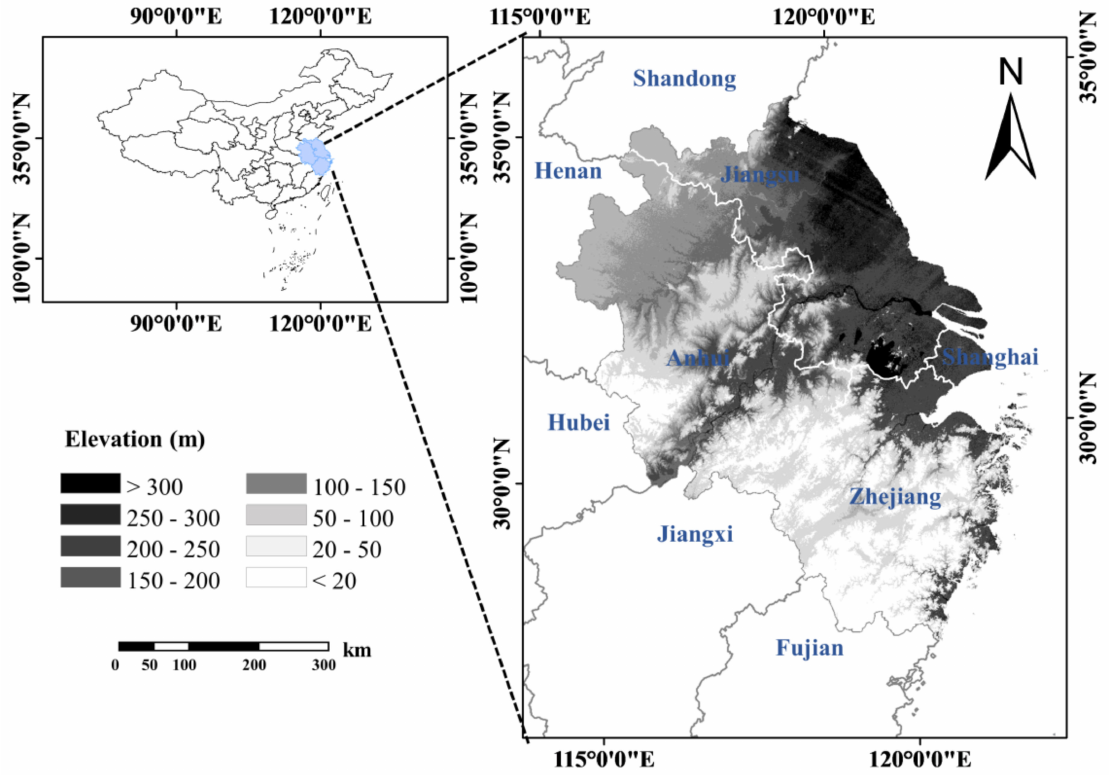
Figure 1. Geographical location of Yangtze River Delta Urban Agglomeration. (China Map from the website of China Standard Map Service (http://bzdt.ch.mnr.gov.cn/, accessed on 1 September 2022), the Map Review Number is GS (2020)